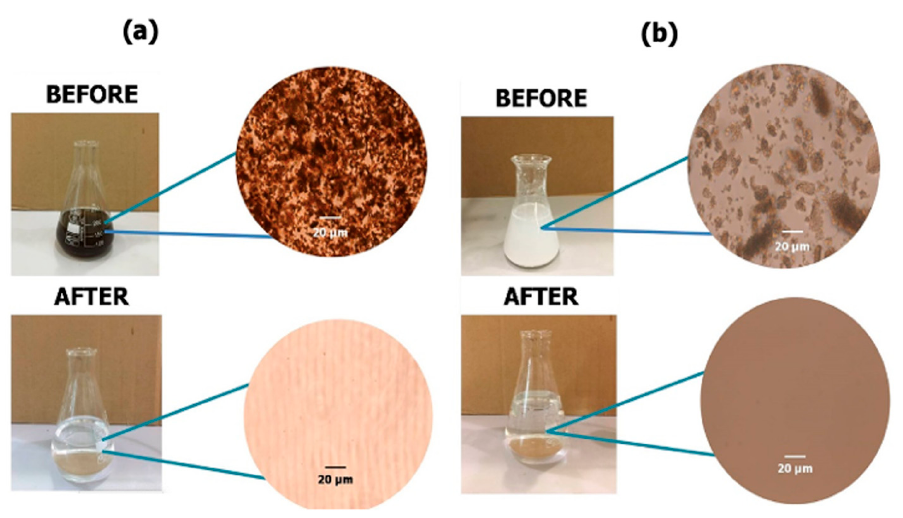
Figure 8. Microscopic images of ( a ) animal pond wastewater and ( b ) laboratory wastewater before and after the filtration process using the developed microsphere-templated porous monolith.